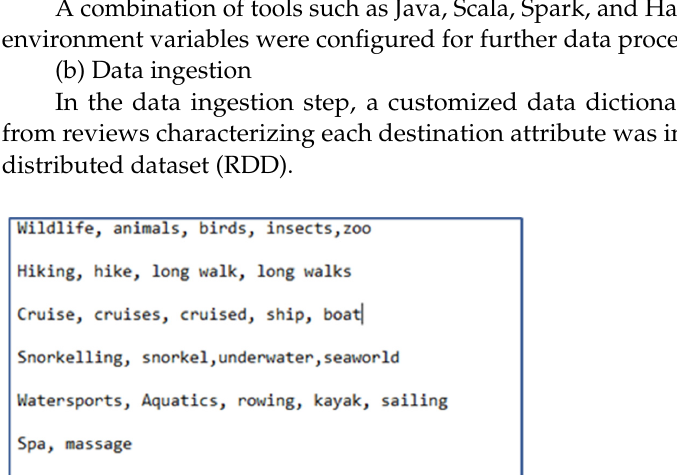
Figure 9. Example reviews extracted for a destination.